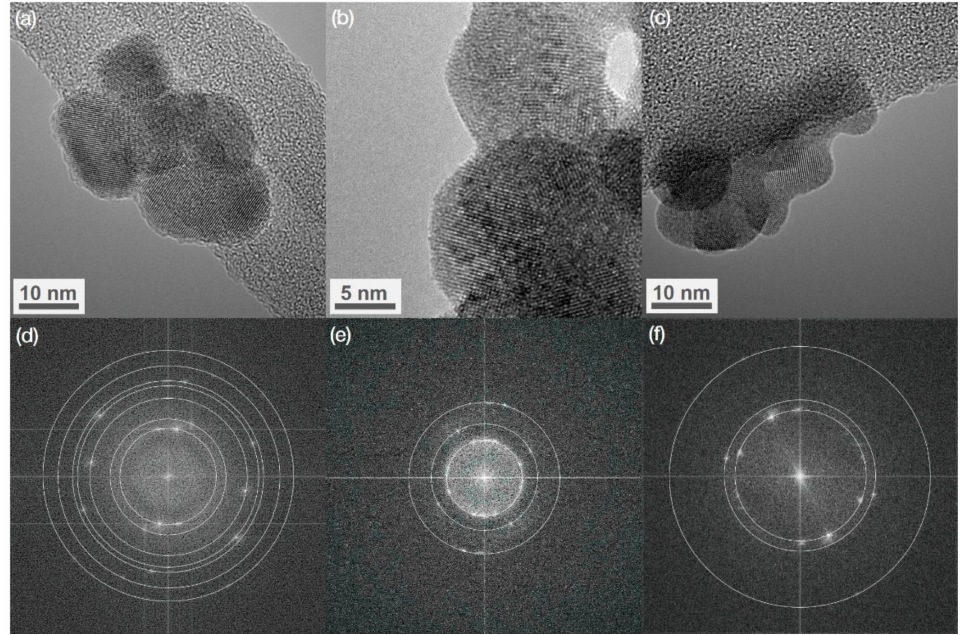
Figure 2. HRTEM images of ( a ) BaGdF 5 :Eu, ( b ) BaGdF 5 :Tb, and ( c ) BaGdF 5 :Sm; ( d – f ) FFT images with circles marking the spacing between atomic planes.